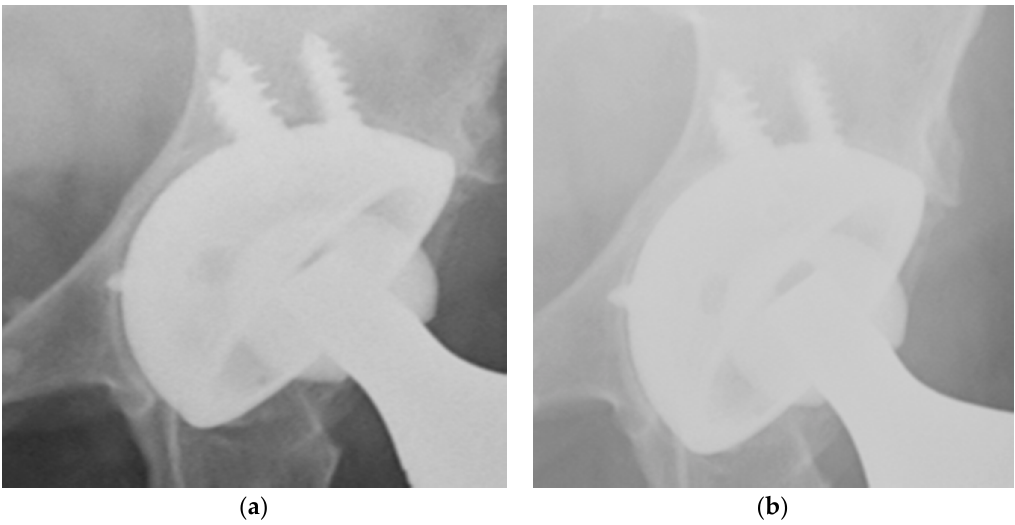
Figure 2. X-rays show good osteointegration of the implant and formation in a 72-year-old woman treated with cup revision for a Paprosky 3a. ( a ) One month follow-up, presence of radiolucent lines, ( b ) One year follow-up, shows filling of the radiolucent line with the formation of new bone.